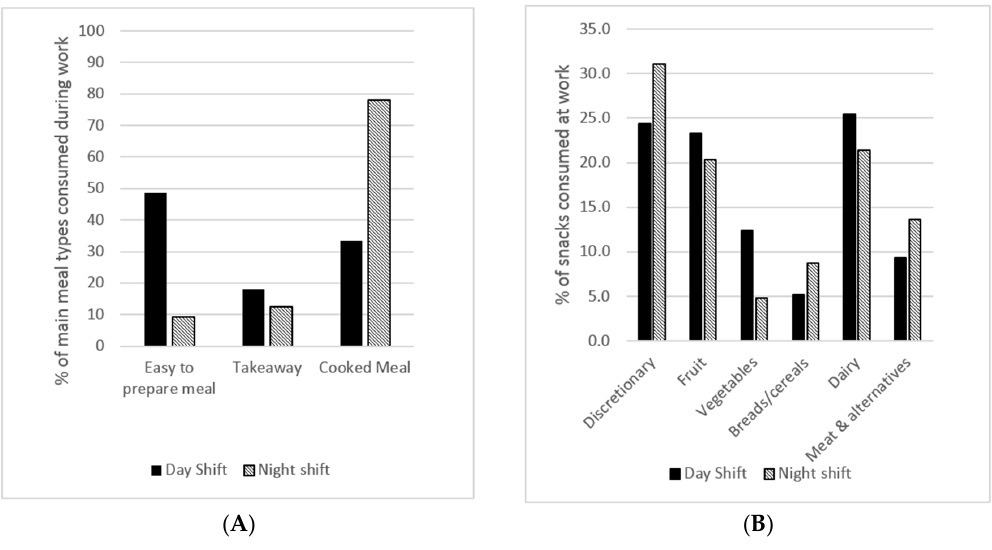
Figure 1. Comparison of main meal and food groups consumed by rotating shift workers ( n = 19) comparing dietary intake from day shift and night shift: ( A ) Categories of main meals were identified during focus groups. Easy ‐ to ‐ prepare meals included sandwiches, rolls, wraps, or salads, or heat ‐ and ‐ serve dishes (e.g., microwave rice); ( B ) snacks were categorised according to the Australian Guide to Healthy Eating food groups ( n = 296 snack foods consumed over 70 snacking occasions). Energy intakes (kJ/day) were not different between day or night shift (Table 4). A significantly higher percentage energy from sugar was observed during the 24 h period that included a night shift compared with the 24 h period that included a day shift ( p = 0.036). There were fewer eating occasions, and a greater overall energy density (ED energy , kJ/g/day) of the diet during a 24 h period that included a night shift compared with a day shift period ( p < 0.05, Table 4). Table 4. Median dietary intake of shift workers ( n = 19) using 24 h dietary recalls.